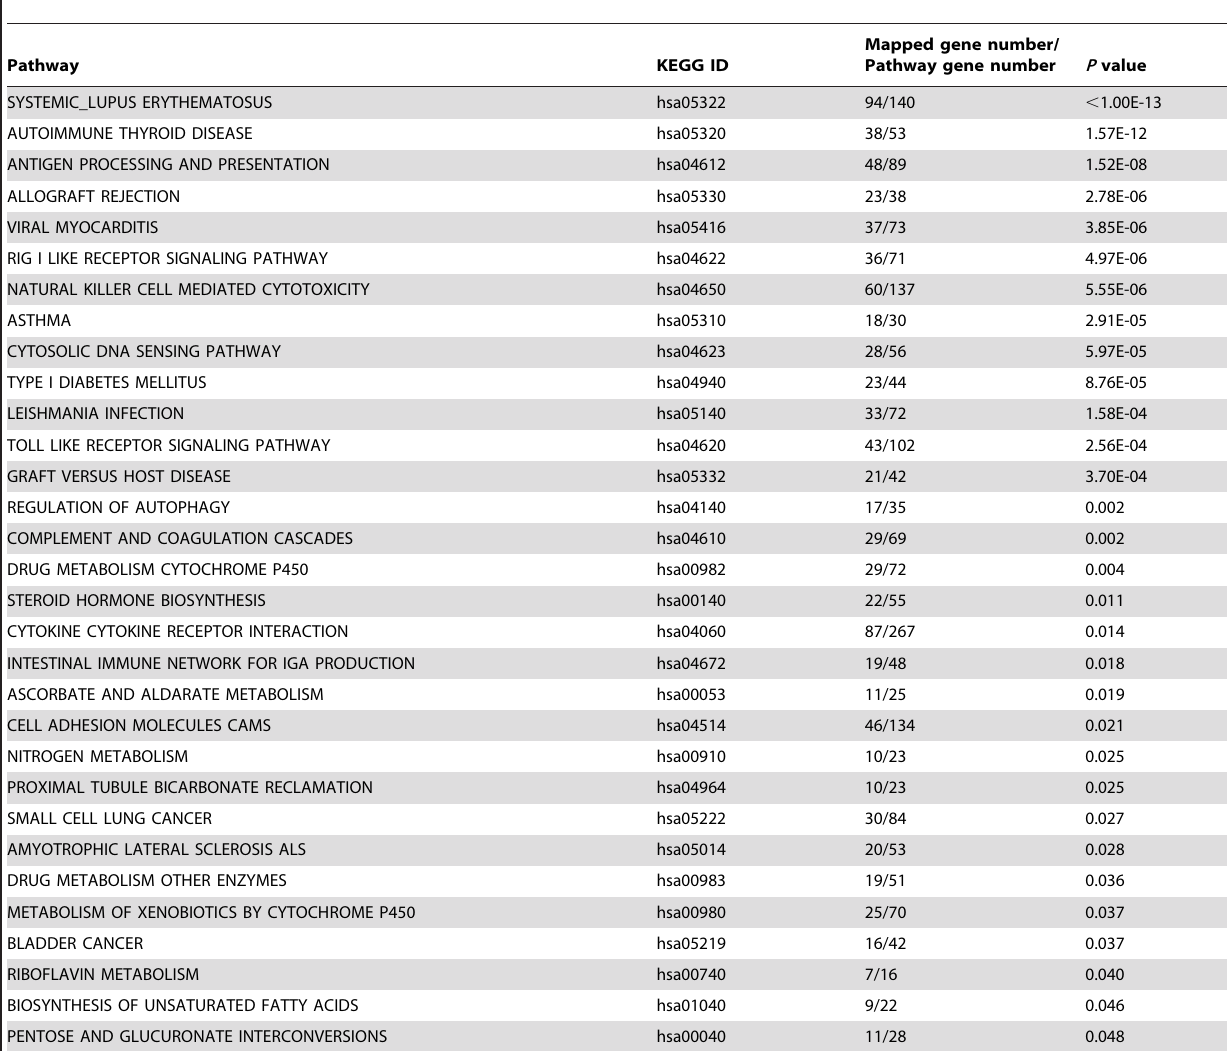
Table 2. The functional KEGG pathways enriched with genes located on the chromosomal segments with significant CNAs in all